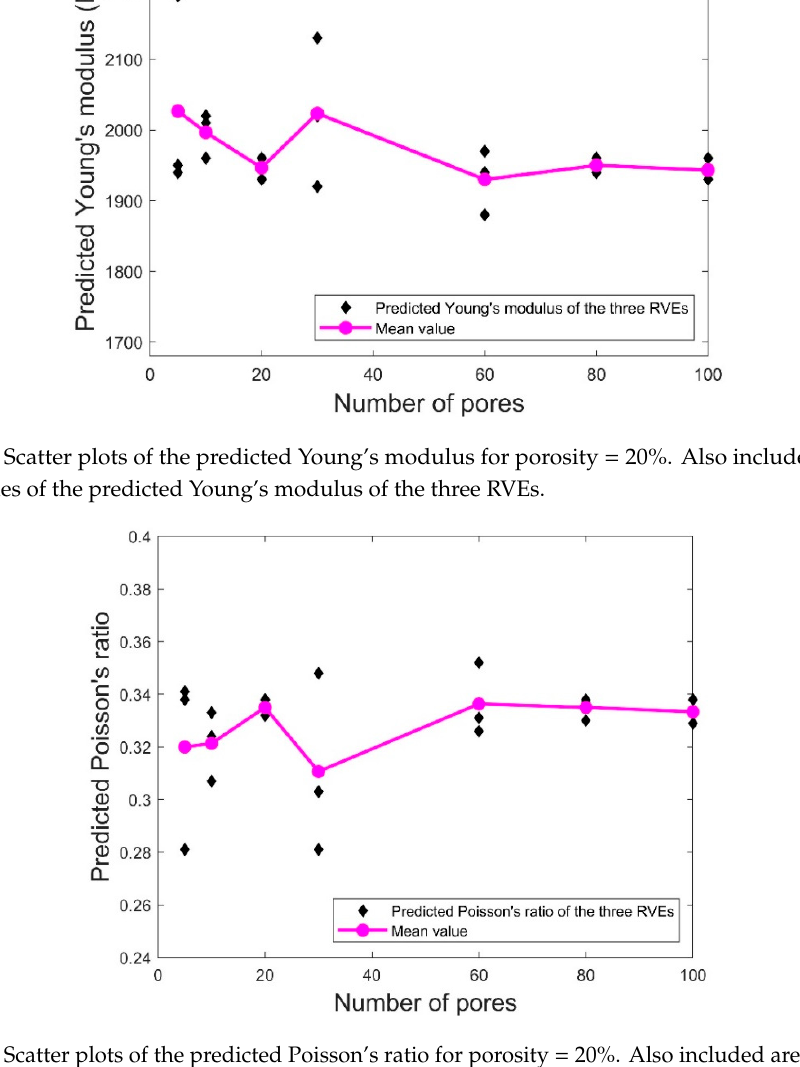
Figure 13. Scatter plots of the predicted Poisson’s ratio for porosity = 20%. Also included are the mean values of the predicted Poisson’s ratio of the three